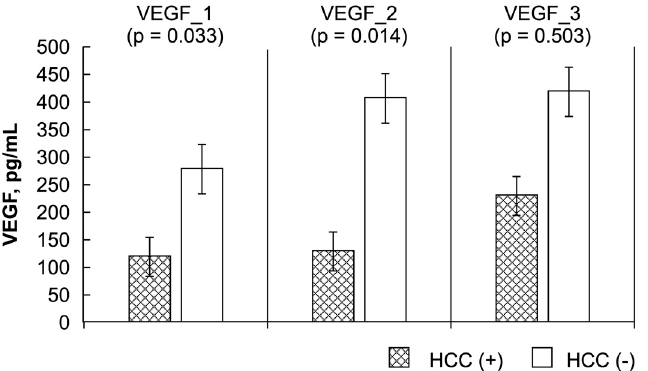
Fig 5. Statistical analysis of FGF-2, survivin, Ki67, endostatin, and VEGF levels, as measured by ELISA before (_1), early after (_2), and late after (_3) after living donor liver transplantation (LDLT). The Mann-Whitney U test was used to compare the differences in the biomarkers at the various time points between the recipients with and those without HCC recurrence.